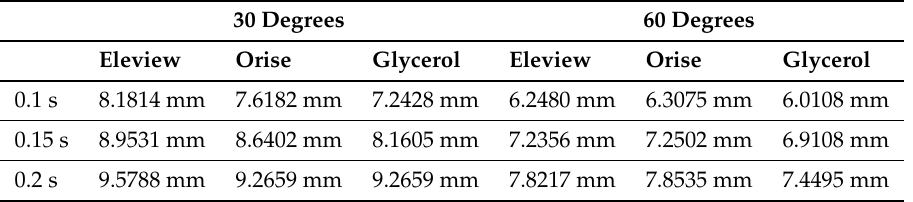
Table 1. Variation of maximum lift achieved at 30 degrees.